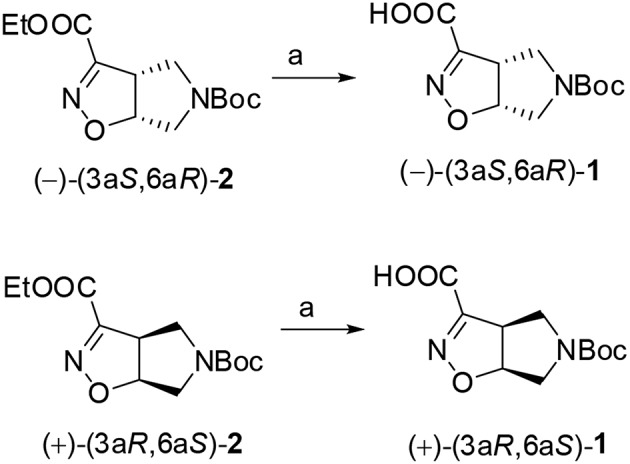
1N NaOH, MeOH, r.t., 1h.